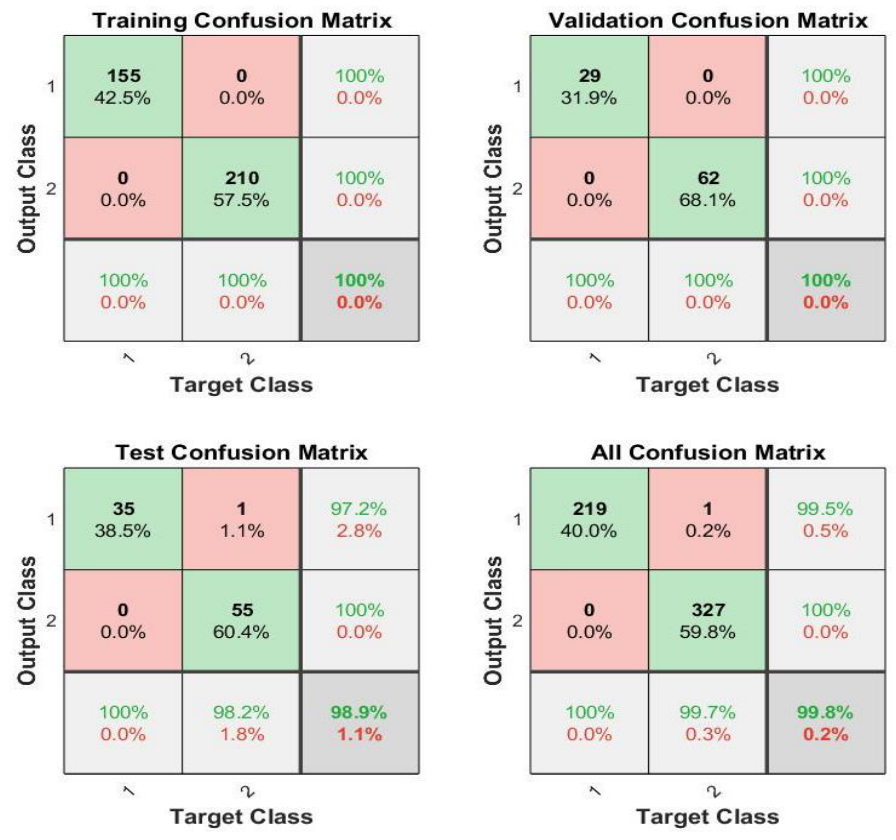
Figure 16. Confusion matrix for ANN algorithm of ASD dataset.